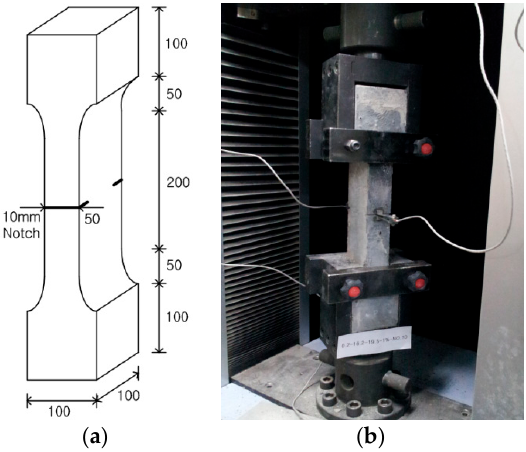
Figure 2. Specimen geometry and the setup for the direct tensile test: ( a ) The details of the specimen; ( b ) the experimental setup for the test.